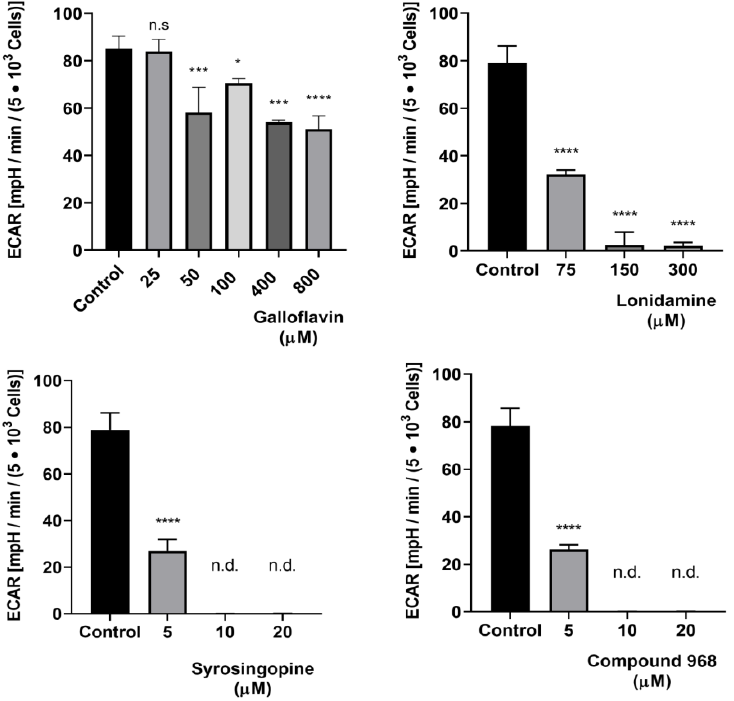
Figure 7. Effects of galloflavin, lonidamine, syrosingopine and compound 968 treatments on glycolysis in uninfected HCT-8 cells cultivated at hyperoxic (21% O 2 ) condition. Glycolysis stress test revealed a significant reduction of glycolytic responses by selected inhibitors. Bars represents mean ± SD, ( n = 3). Data were evaluated for significance by one-way analyses of variance (ANOVA) followed by Dunnett’s test. n.s = non-significant, n.d. = non-detectable, * = p ≤ 0.05, *** = p ≤ 0.001, **** = p ≤ 0.0001.